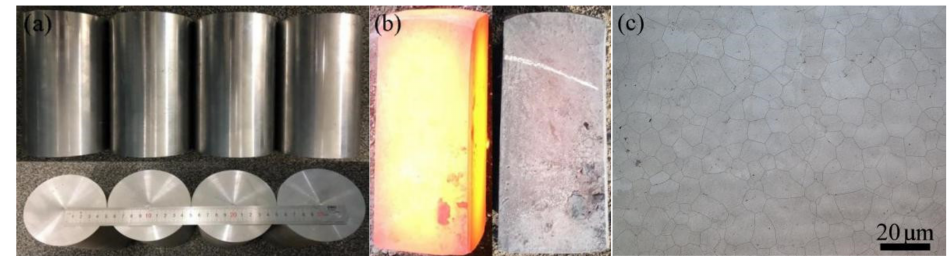
Figure 9. M50 steel forging specimens at a temperature of 1150 ◦ C and a strain rate of 1 s − 1 . ( a ) Specimens before forging; ( b ) Specimens after forging and annealing treatment; ( c ) Microstructure of the